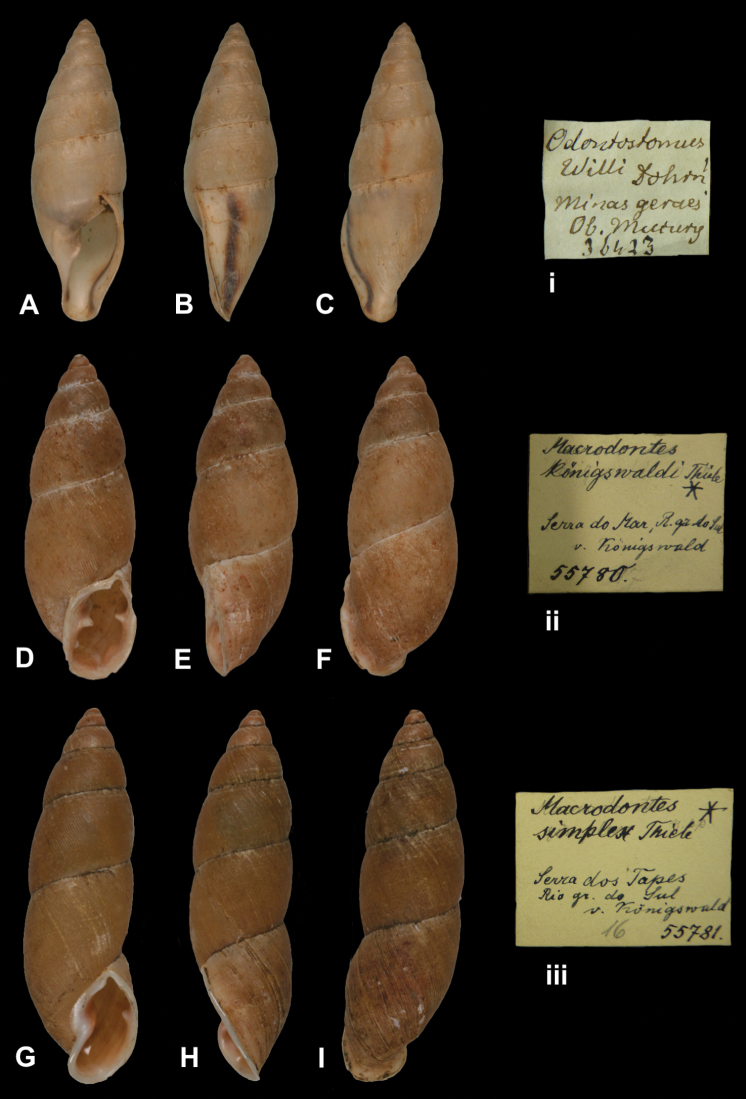
A–C, i
Moricandia willi (Dohrn, 1883), syntype ZMB 36423 (H = 27.9) D–F, ii
Odontostomus koenigswaldi (Thiele, 1906), holotype ZMB 55780 (H = 30.5) G–I, iii
Odontostomus simplex (Thiele, 1906), holotype ZMB 55781 (H = 34.9). All enlarged.